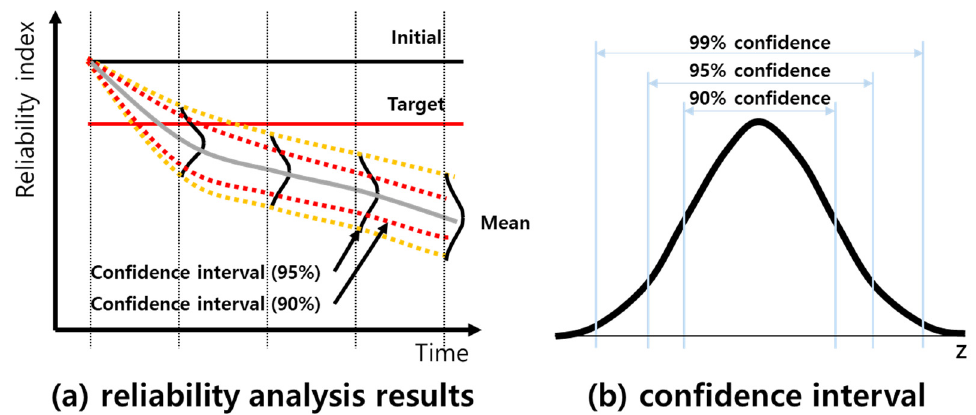
Figure 11. ( a ) Reliability analysis results with confidence interval; ( b ) confidence interval.